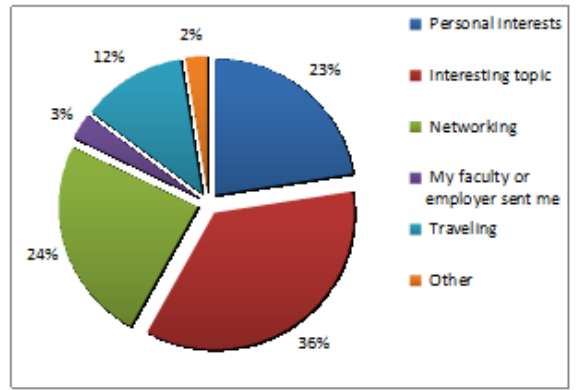
Figure 6. Graph showing the survey respondents’ answer to the question: “what was your primary goal when you decided to